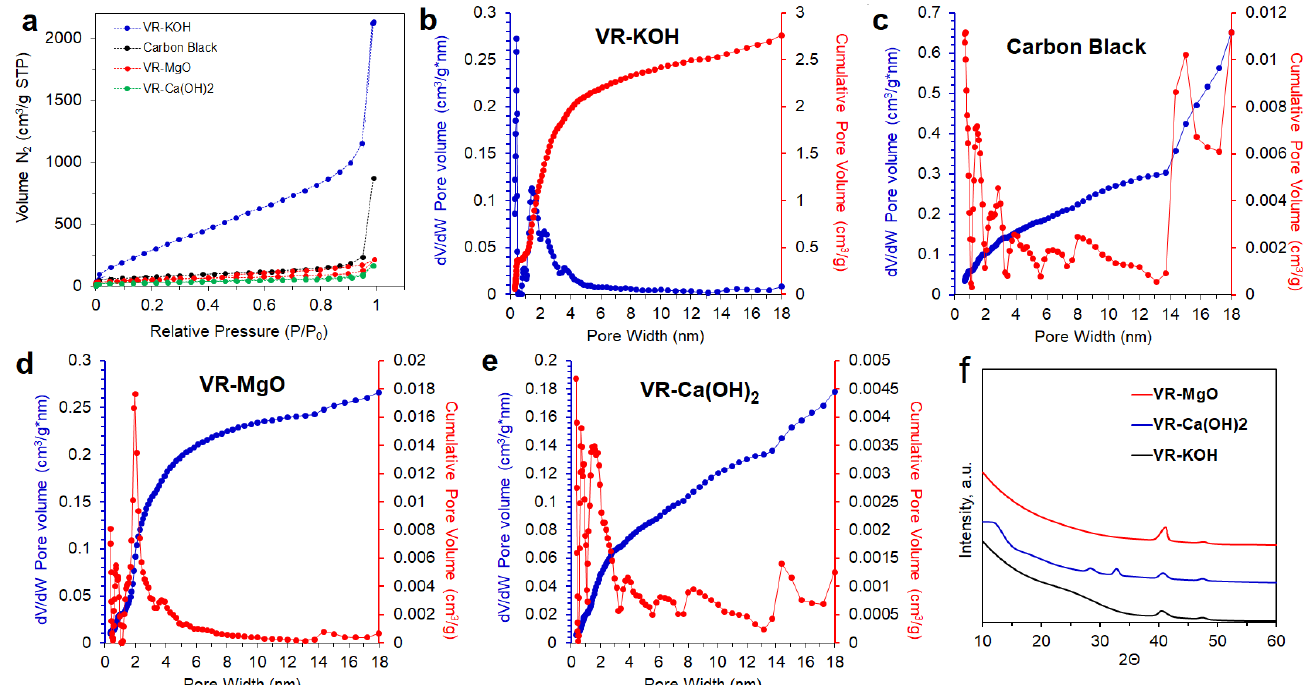
Figure 3. ( a ) Comparative N 2 -adsorption isotherms classified as type I for VR-KOH, carbon black, VR-MgO, and VR-Ca(OH) 2 ; pore-size distribution curves for ( b ) VR-KOH, ( c ) carbon black, ( d ) VR-MgO, and ( e ) VR-Ca(OH) 2 determined using the NLDFT and ( f ) XRD pattern of VR-KOH, VR-MgO, and VR-Ca(OH) 2 .